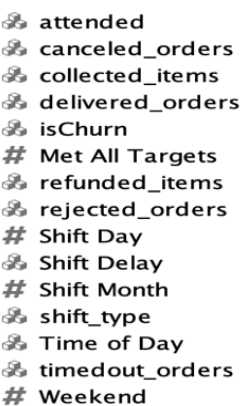
Figure 8. Sample of important selected variables.